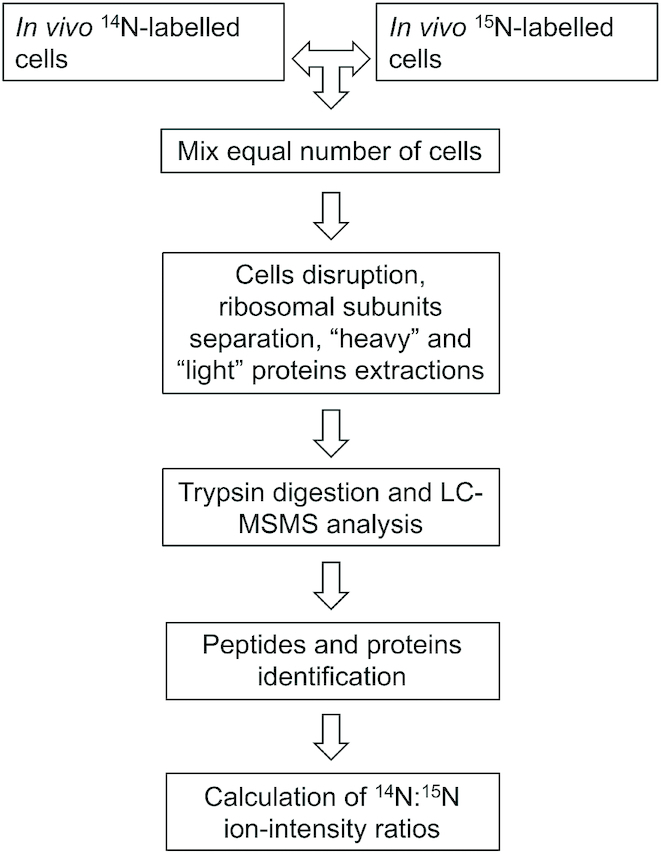
Flow chart illustrating the experimental strategy used for the mass spectrometry analyses. Two cell populations were grown in parallel in M9 culture media, identical except for the presence of 15NH4Cl in one case and of 14NH4Cl in the other. This results in the synthesis of ‘heavy’ and ‘light’ proteins, respectively. The culture to be evaluated (light) and the reference culture (heavy) were mixed together just before each step of sample preparation, thus reducing the experimental error that would distort the quantitative result. The proteins were digested and prepared for the LC–MS/MS analysis, and the data processed using software for quantitative proteomics that can handle metabolic labeling (see Materials and Methods). The MS/MS spectra were used to identify the peptides, the software algorithm for quantitative proteomics extracted individual MS1 isotopes and calculated peptide AUC ratios for each peptide pair. The weighted average of all peptide ratios was calculated for each protein as a value for the protein ratio.